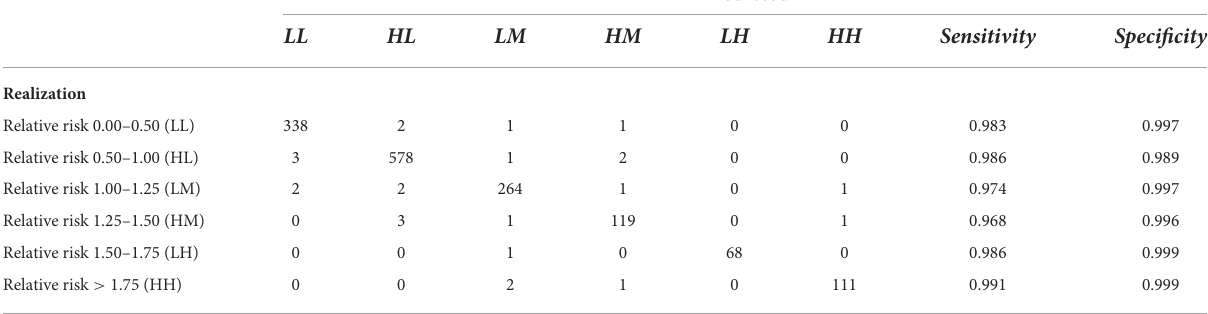
TABLE 9 Confusion matrix for September 2020 prediction of relative risk of COVID-19